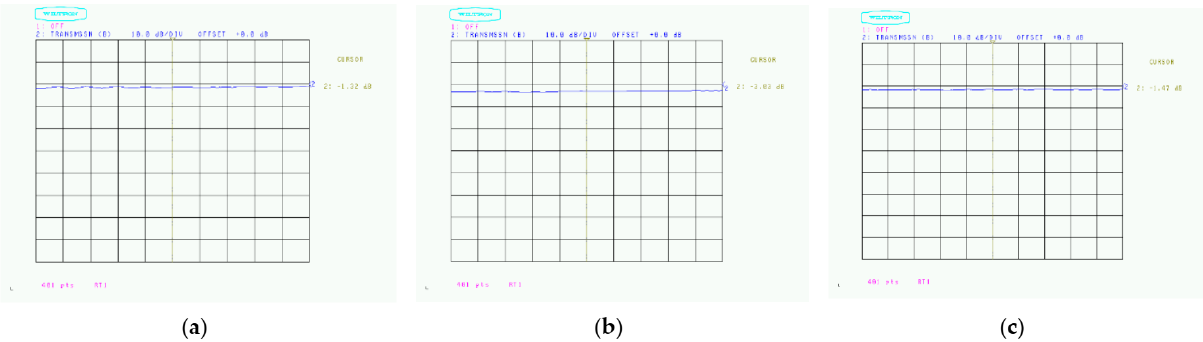
Figure 17. Radio wave absorption of carbon black paint: ( a ) Coating thickness 16 µ m lower part (1.32 dB); ( b ) Coating thickness 35 µ m upper part (3.03 dB); ( c ) Coating thickness 75 µ m upper part (1.47